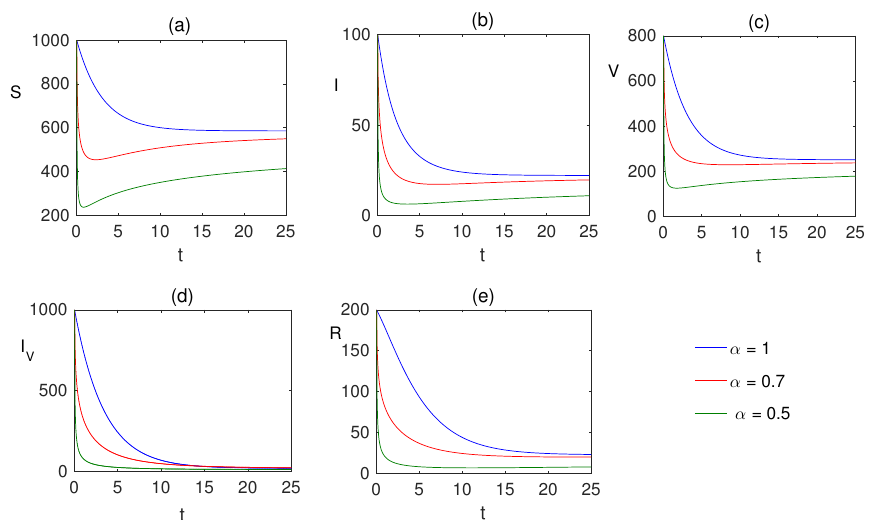
Figure 3. Numerical solution of ( a ) susceptible S ( t ) , ( b ) infected I ( t ) , ( c ) vaccinated population V ( t ) , ( d ) infected population after vaccination I V ( t ) and ( e ) recovered populations R ( t ) are plotted for showing the dynamics of the fractional model (7) when α = 1, 0.7, 0.5, and the fear factors are α 1 = 0.0029 and α 2 = 0.002.